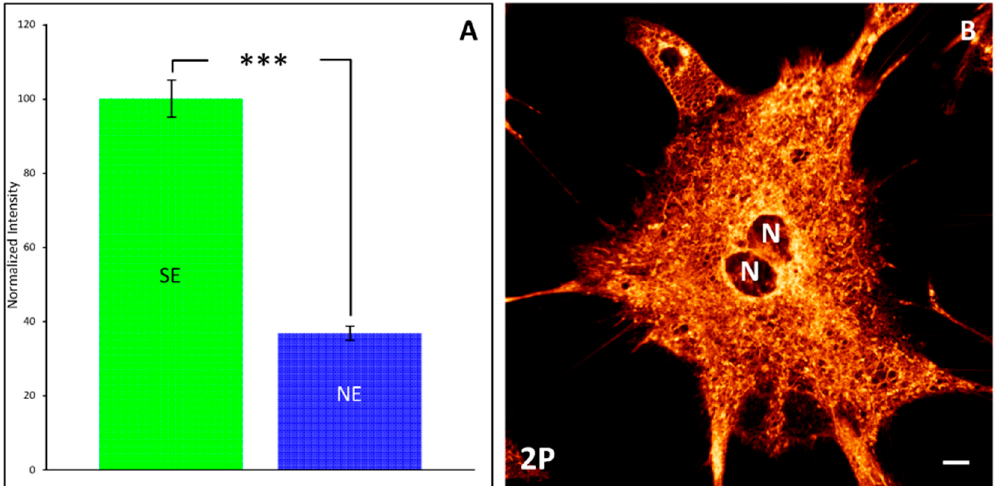
Figure 15. Characteristics of synthetic epicocconone (SE) and natural epicocconone (NE) through nonlinear optical microscopy. ( A ) Comparison of fluorescence intensity obtained by cell imaging with synthetic analogue of epicocconone (SE) and the natural product epicocconone (NE). *** p < 0.001 vs. SE. ( B ) Cell labeling with the naphtyl analogue of epicocconone through 2P microscopy. N = Nucleus. Scale: 10 µm. Modified with permission from [113]. Copyright 2017 Elsevier.